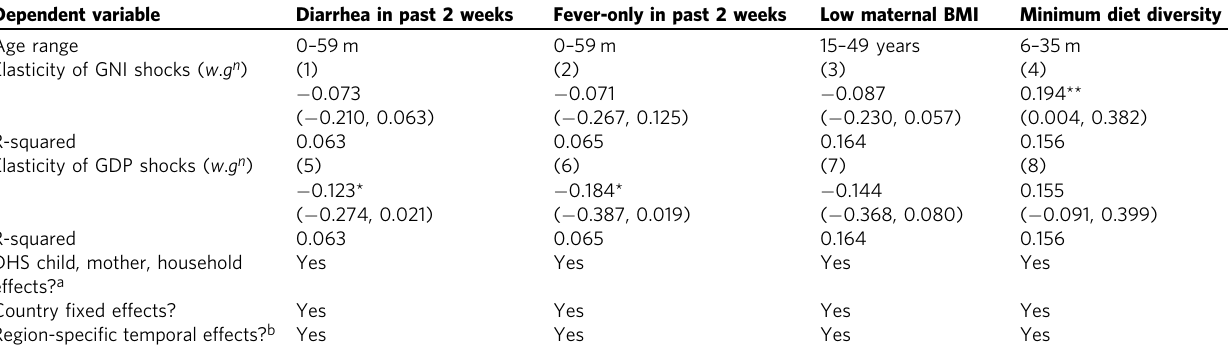
Table 3 Exploring disease, maternal nutrition and diet mechanisms linking GNI or GDP growth shocks to child